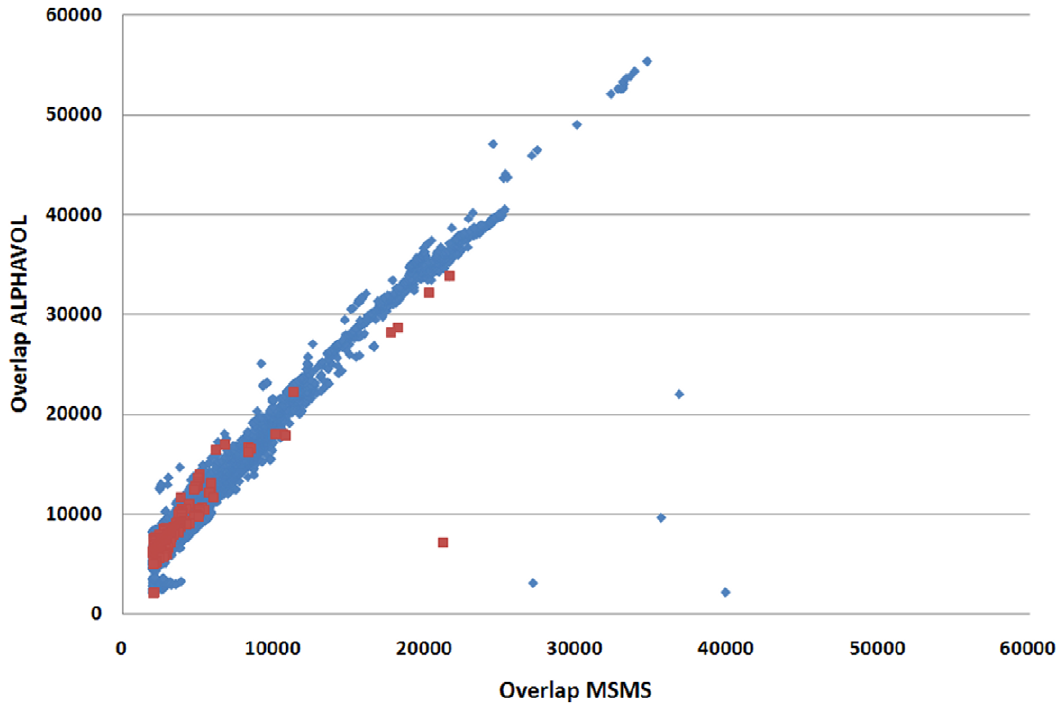
Figure 2. Correlation of the results generated by the two collision detection methods MSMS and ALPHAVOL. All overlap values detected by the two methods are shown in blue. The correlation of all results (12,772 protein interaction pairs) is 0.98. The filtered results are shown in red. Considering only these filtered results (4,874 protein interaction pairs), the correlation between the two methods slightly decreases to 0.90.